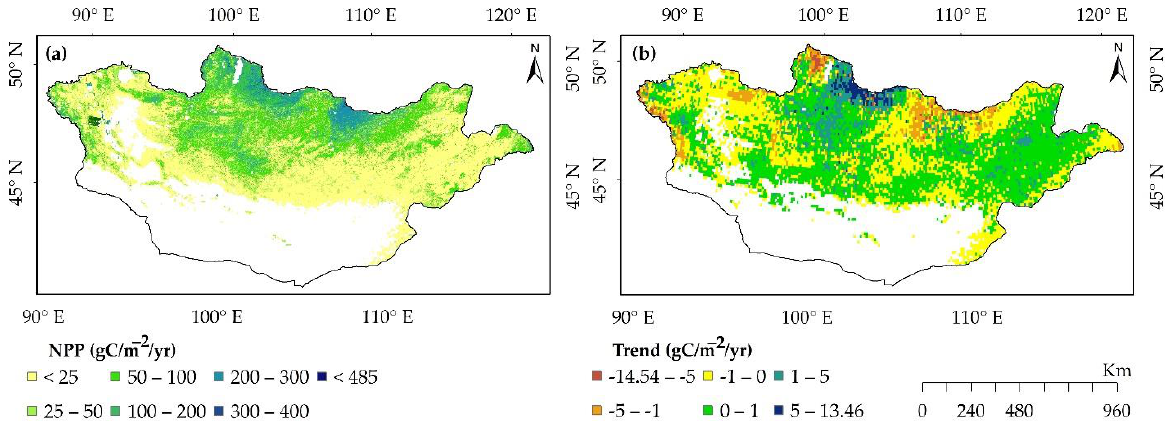
Figure 4. ( a ) Spatial distribution of mean growing season NPP across Mongolia from 2003 to 2018. ( b ) The spatial distribution of the trend in growing season NPP during the study period. The white-colored areas on land are non-vegetated pixels. Table 3. Statistic summary of the percentages of pixels showing different trends in growing season NPP and climatic variables across Mongolia during 2003–2018.